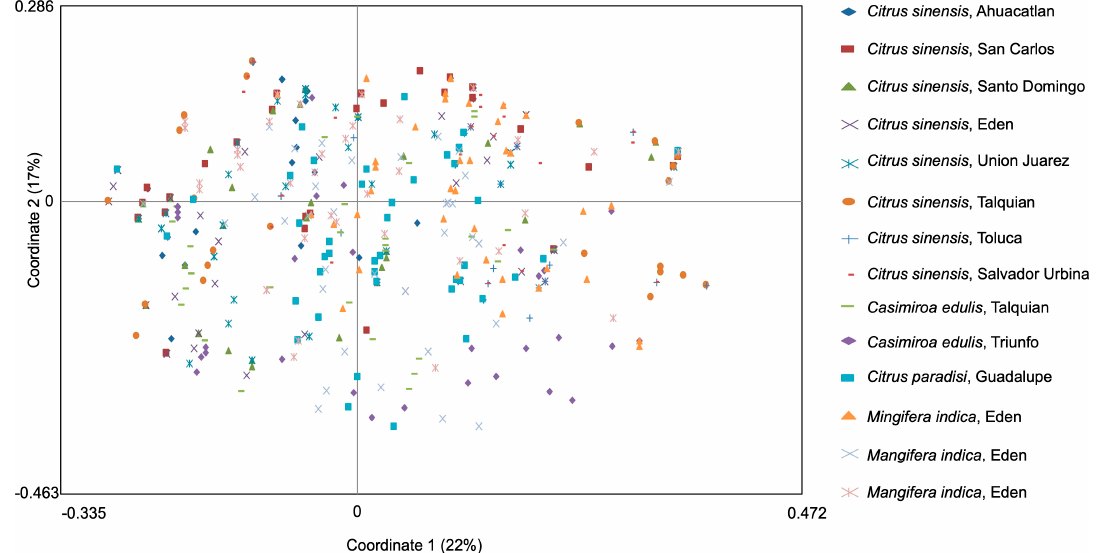
Figure 3. Principal coordinates analysis (PCoA) via covariance matrix with data standardization on genetic distance values.